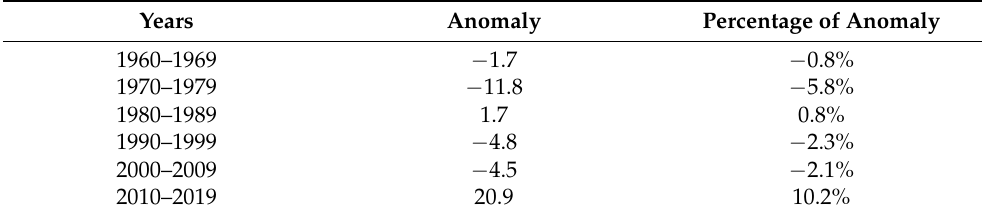
Table 1. Interdecadal anomaly of the rainstorms and floods in summer half-year for 1961–2021.